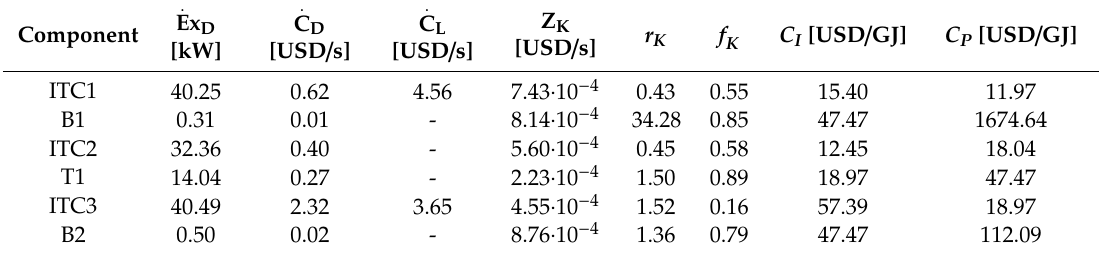
Table A4. Exergy destroyed by Component, Exergy destruction costs and Di ff erence of relative cost and exergo-economic factor by system component